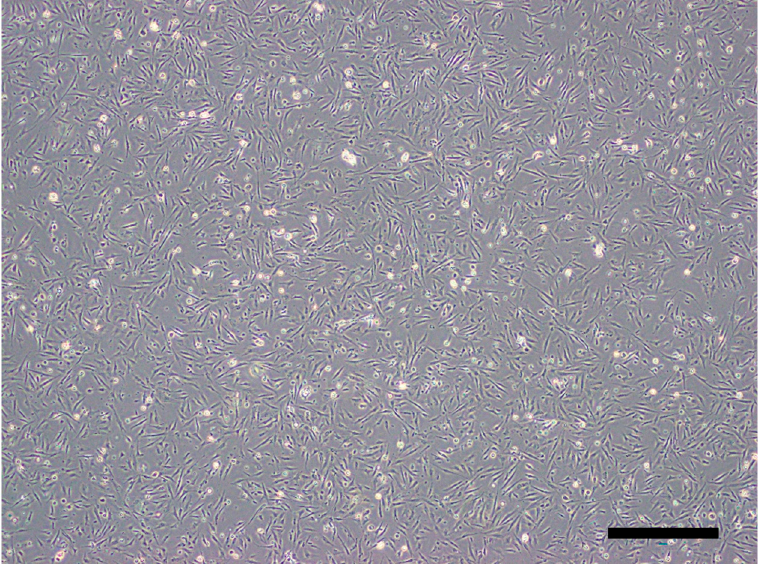
Figure 1. Olive flounder intestinal epithelial cells (IECs) visualized by phase-contrast microscopy at 96 h post-seeding (40× magnification) (scale bar = 500 µm).